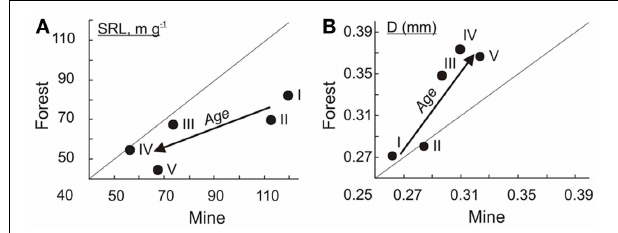
FIGURE 3 | Mean values of birch EcM root SRL (A) and diameter (B) in five different ages classes (I:3, II:6–7, III:14–20, IV:30–32,V:41–45years.) in forest vs on mine area. The arrows indicate the direction of increasing stand age.